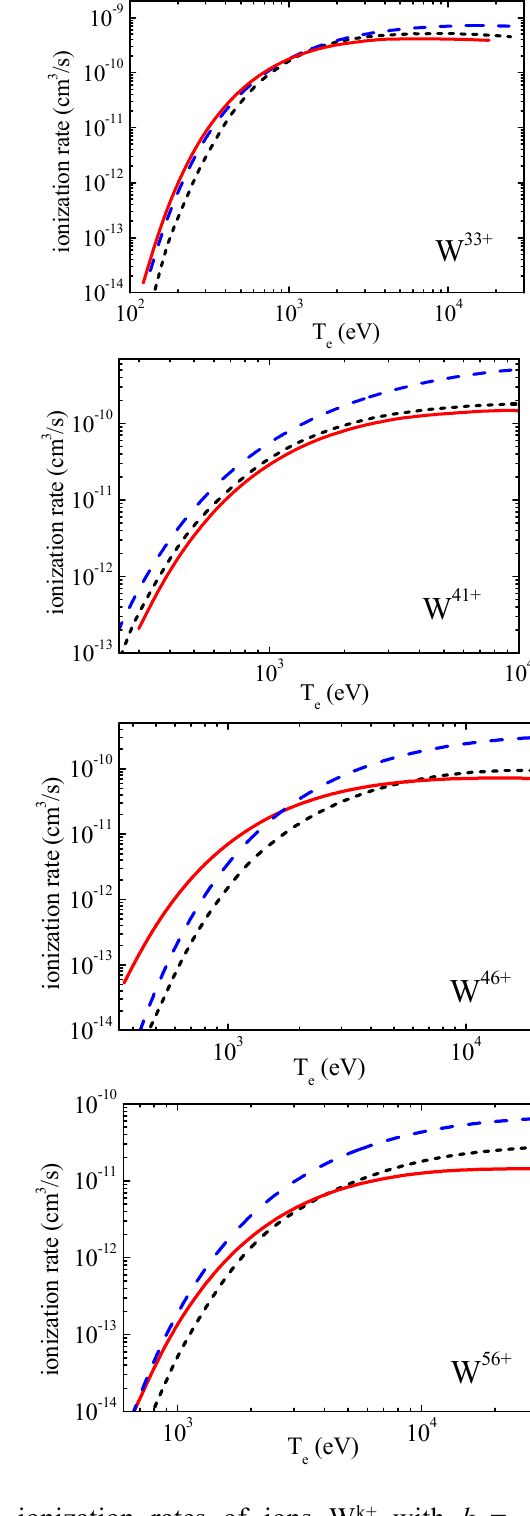
Figure 8. Comparison of electron impact ionization rates of ions W k+ with k = 28,33,38,41,44,46,51,56: solid curves—present statistical model; dashed curves—code ADPAK data [1], short dashed curve—CADW modeling data